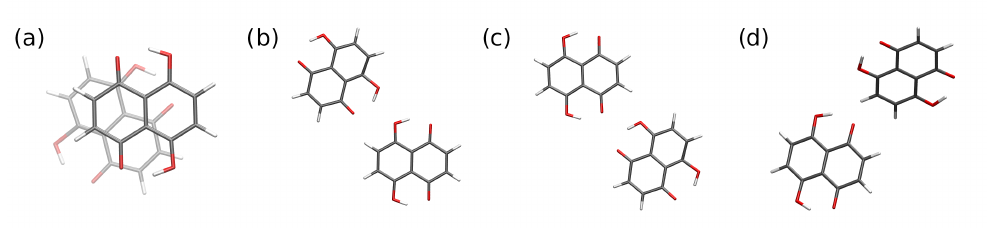
Figure 7. Dimers of Naphthazarin selected for the interaction energy analysis. Structures taken from the 60 K neutron diffraction crystal structure [18]. Dimers represent the following interactions: ( a ) stacking, ( b ) and ( c ) hydrogen bonding, ( d ) multipole interaction and possible weak C-H...H